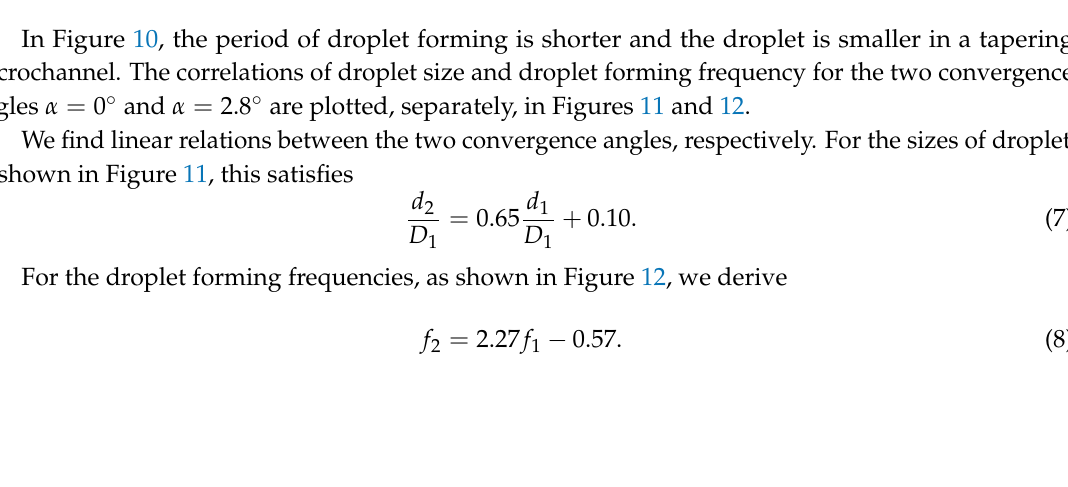
Figure 10. The formation process (one period) of a paraffin droplet under different convergence angles in the Jetting